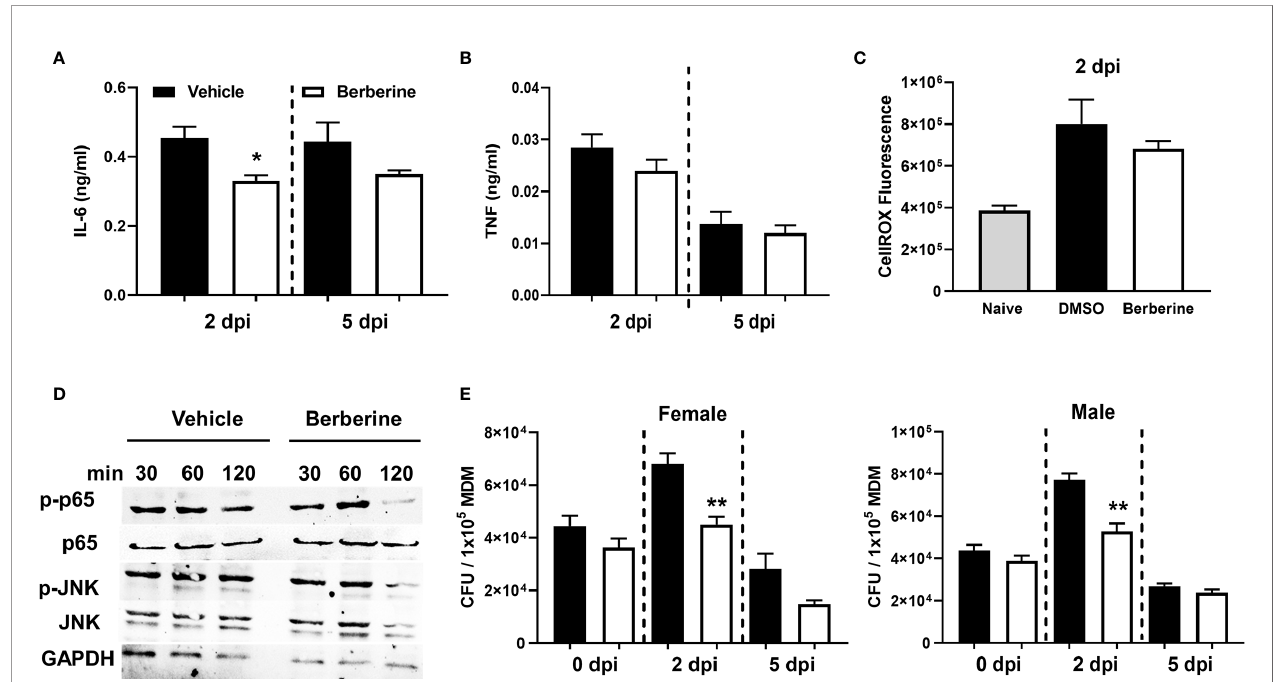
FIGURE 2 | Anti-in fl ammatory effects of berberine in Mtb infected BMDM. Berberine or vehicle-treated BMDM isolated from C57BL/6 mice were infected with Mtb. (A) IL-6, (B) TNF measured in the supernatants 2 days and 5 days post-infection and (C) accumulation of intracellular ROS was measured by CellROX Green reagent at 2 days post-infection. (D) Ser536 phosphorylated p65, total p65, Thr183/Tyr185 phosphorylated JNK, total JNK, and housekeeping control GAPDH levels were assayed by Western Blot in berberine or vehicle pre-treated BMDM at 30, 60 and 120 minutes post Mtb infection. (E) Human monocyte-derived macrophages from male and female donors (n = 3 each) were infected to determine mycobacterial growth at the indicated time points. Data represented as mean ± SEM of four replicates and representative of two experiments. Statistical signi fi cance was analysed by a two-tailed unpaired Student ’ s t-test de fi ning differences in all groups as signi fi cant *P ≤ 0.05; **P ≤